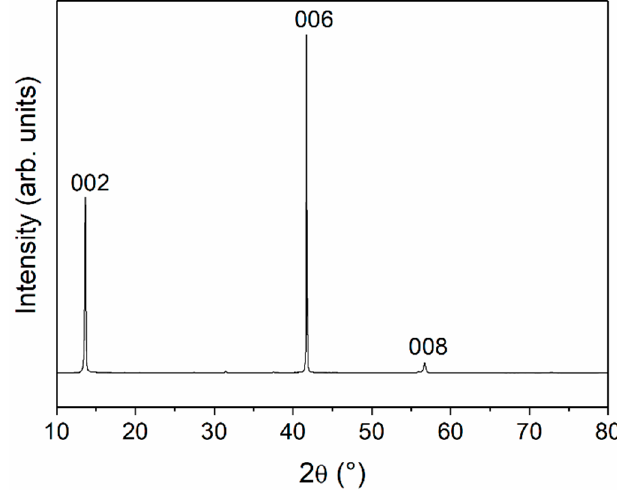
Figure 3. XRD pattern of WSe 2 .